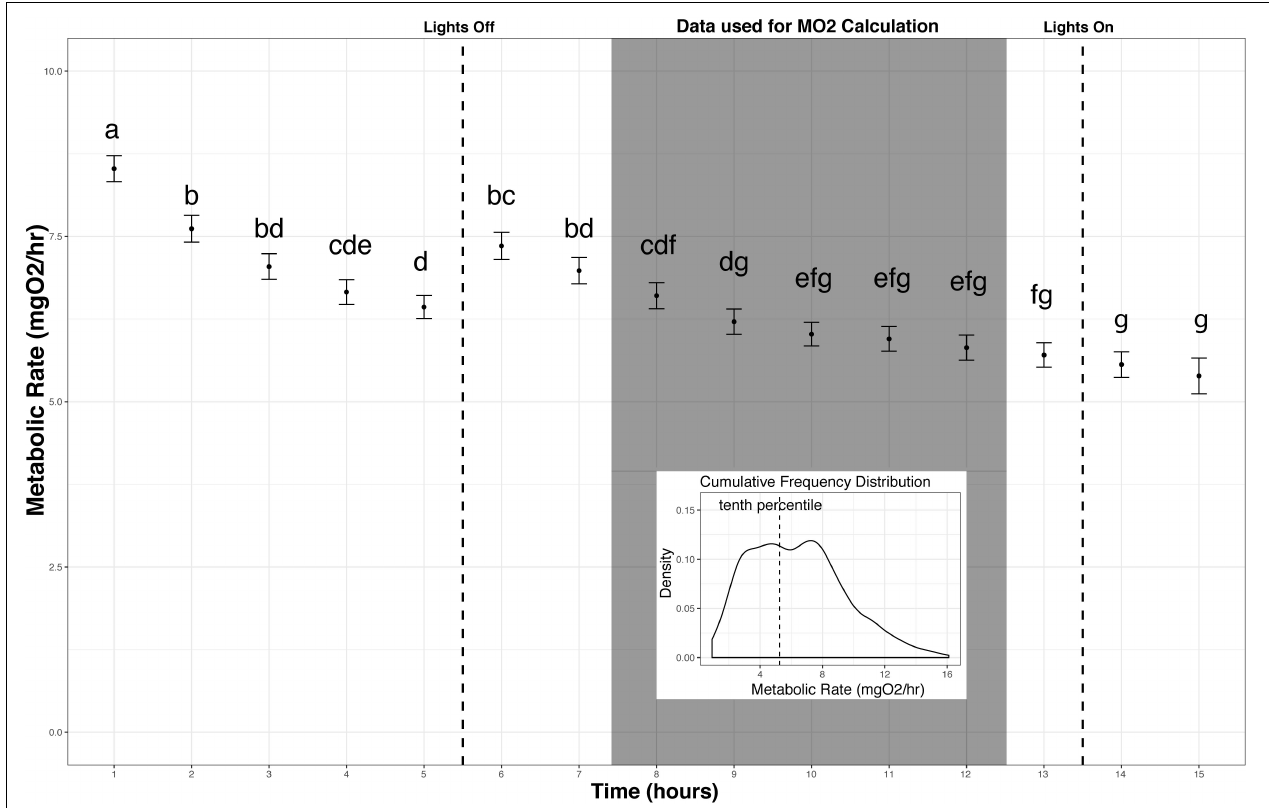
FIGURE 3 | Metabolic Rate measurement over time. Metabolic rate vs. time since fish were added to the chambers (mean and standard error across all individuals on an hourly basis). Fish reached a resting state in the chamber between 3 and 4 h when left undisturbed. Replicates used in calculating metabolic rate (MO 2 ) are indicated (shaded box). Letters indicate significant differences among time points (ANOVA, α = 0.05). Inset: The lower 10th percentile values from the cumulative frequency distribution of this subset of replicates were used to estimate standard metabolic rate for each